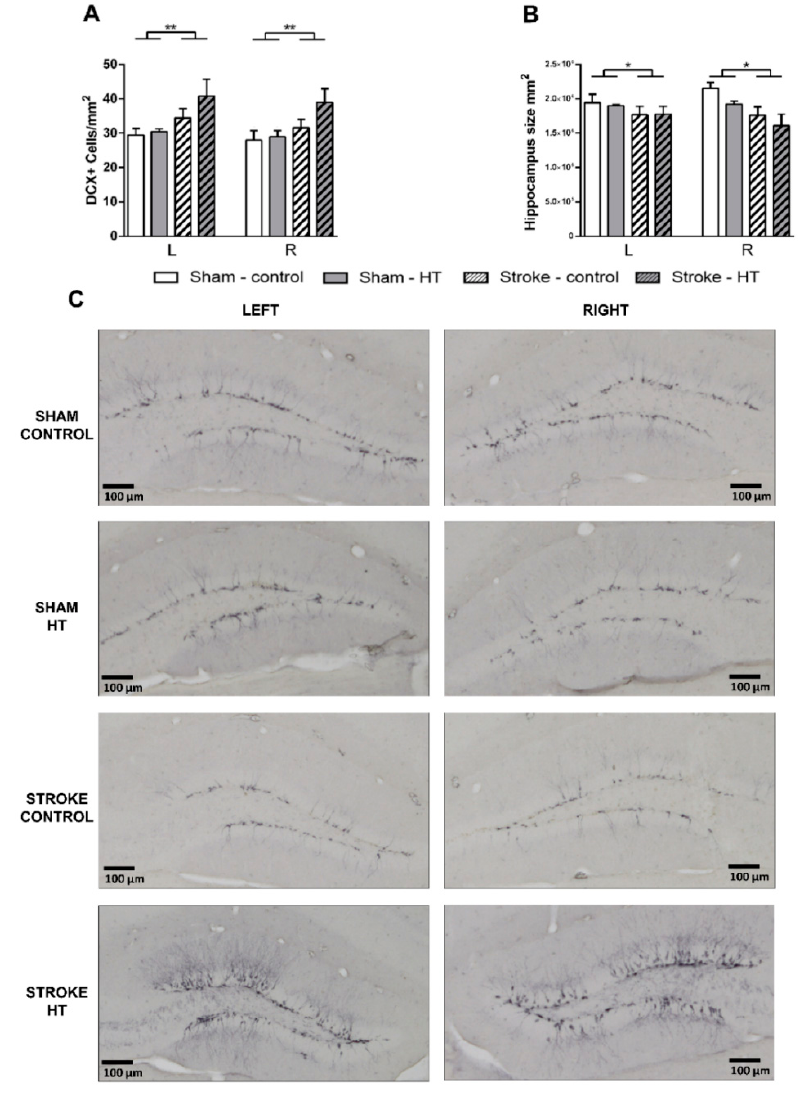
Figure 13. Immunohistochemical stainings for doublecortin (DCX) in hippocampus of the brains of HT and control fed mice 35 days after surgery. ( A ) All stroke mice showed an increased number of DCX+ cells/mm 2 compared to sham mice ( p < 0.008). ( B ) The hippocampus size was reduced significantly in stroke mice without a diet effect ( p < 0.015). ( C ) Representative photos per experimental group are shown. Values represent mean ± SEM. * p < 0.05, ** p < 0.01.